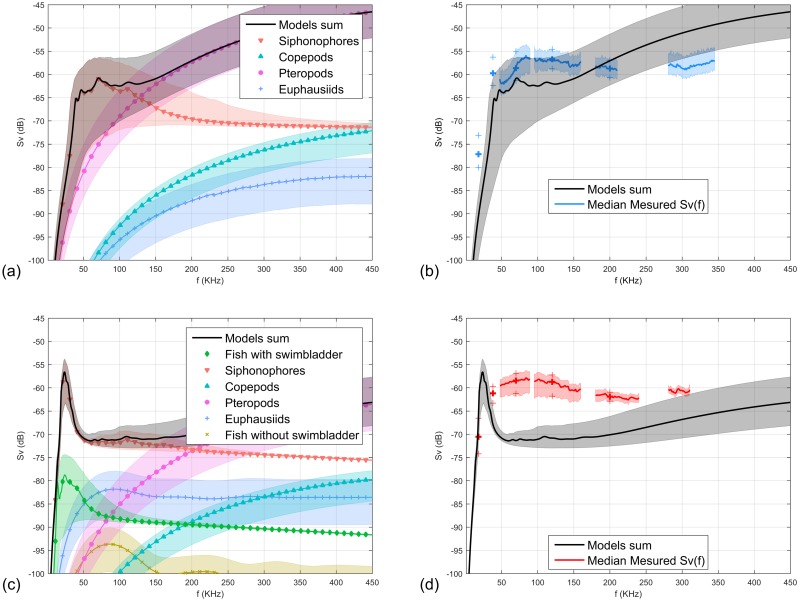
Forward approach results: modeled frequency spectra (Sv(f)) are represented in the left column (Fig (a) for surface layer, (c) for deep layer). Coloured areas: confidence intervals (5th and 95th percentiles of uncertainty analysis results). Measured Sv(f) (red or blue lines) and predicted Sv(f) (black line) frequency spectra are represented in the right column, (Fig (b) for surface layer,(d) for deep layer). Coloured areas around measured Sv(f): confidence intervals (25th and 75th percentiles). Volume backscattering strength Sv level at 18, 38, 70, 120, 200 and 333 kHz and their 25th and 75th percentiles confidence intervals are represented by crosses.